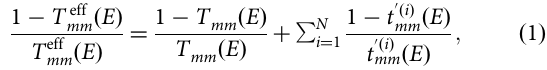
Fig. 5 Sheet resistance for δ -layer systems. Comparison of the computed sheet resistance R □ for two values of the linear impurity density α vs. experimental data 5,35 – 37 in the function of the doping density in the δ -layer N D . Figure reproduced with permission from Mendez et al. 49 , IEEE.